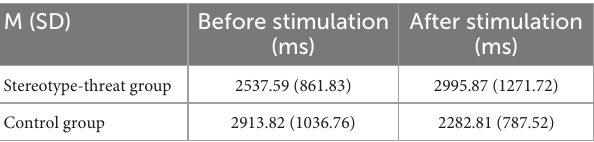
After stimulation (ms) (ms)